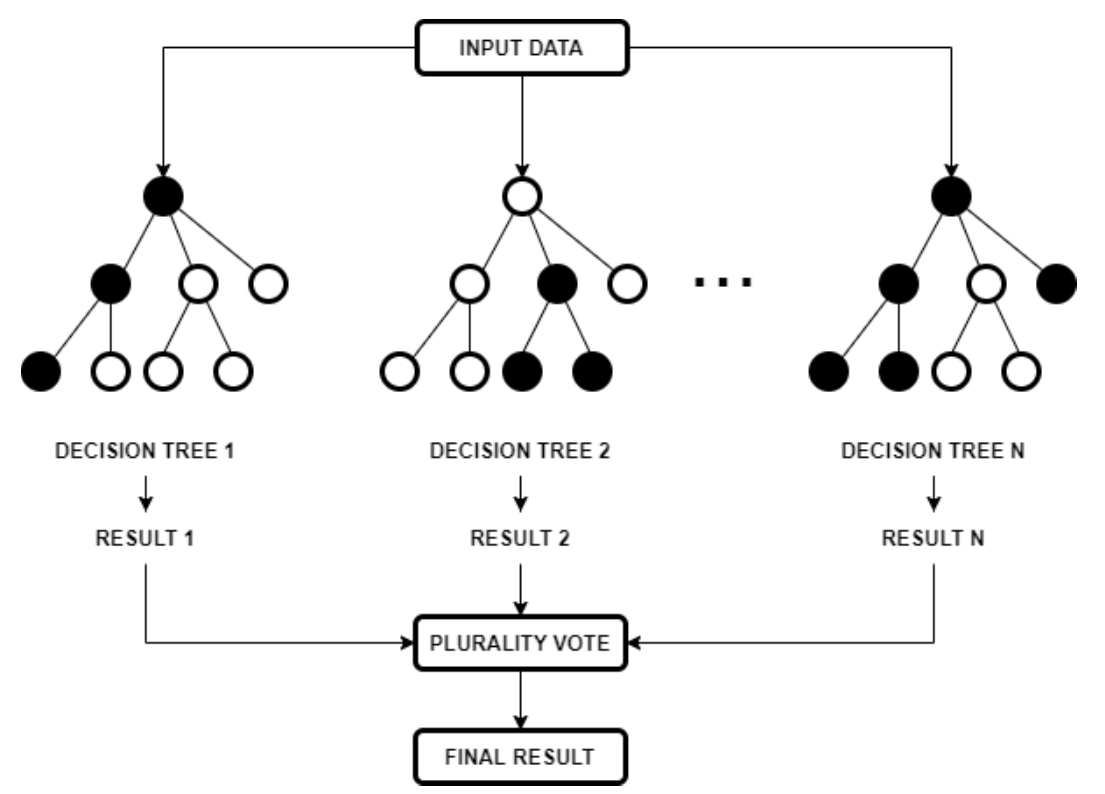
Figure 3. Generalized diagram for the functioning of a random forest classifier.